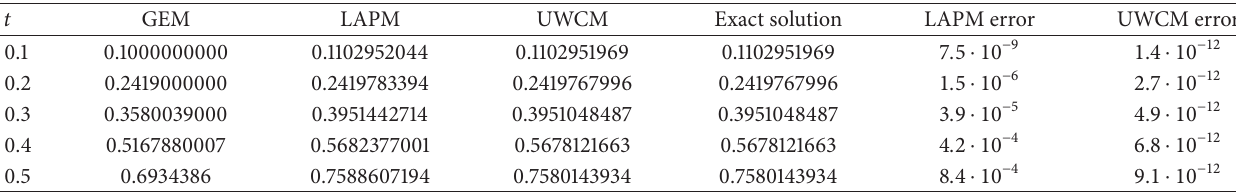
Table 1: Comparison between UWCM, GEM, and LAPM for Example 8 for 𝛼 = 1 .